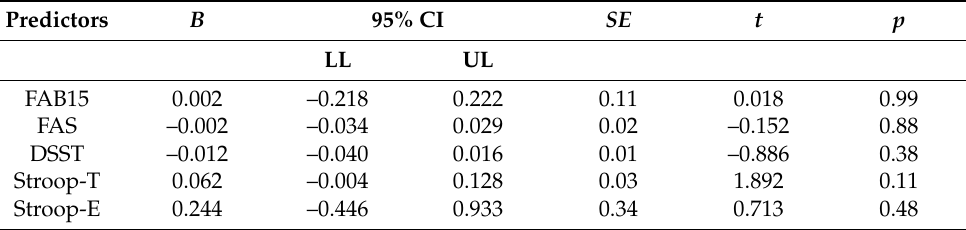
Table 3. Results of Multiple Linear Regression Analysis on BMI